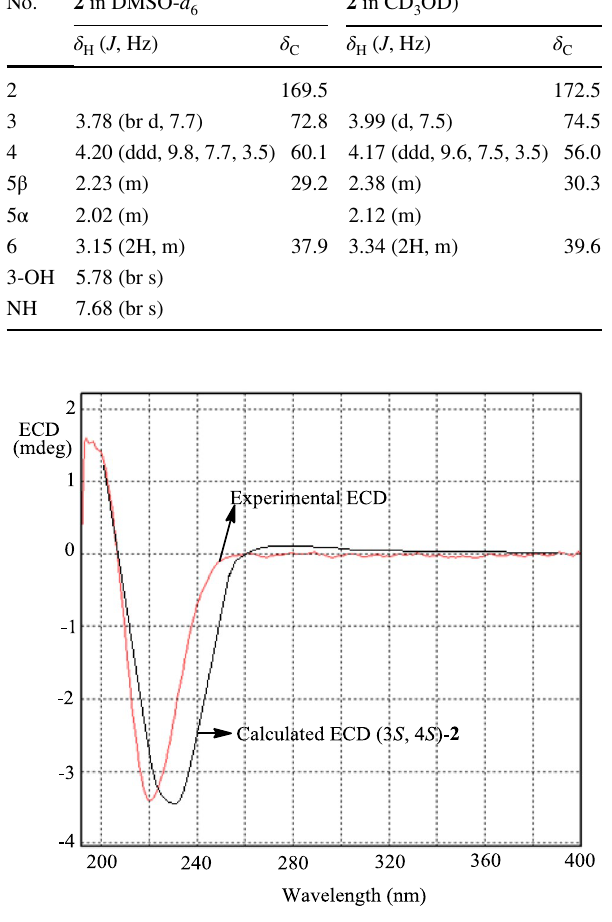
Fig. 3 Experimental and calculated ECD for compound